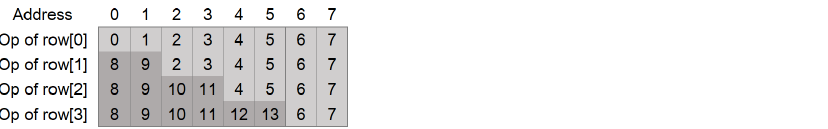
Figure 9: Details of the column-block eliminations in this work for ( n − k, s ) = (8 ,